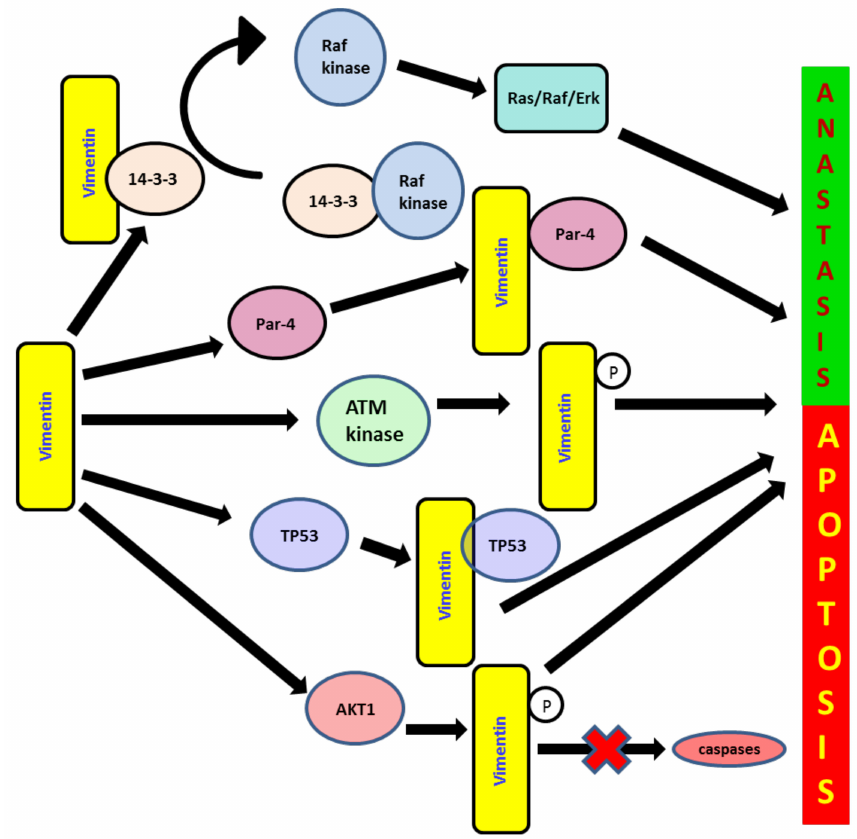
Figure 3. Loss of apoptosis and anastasis, “recovery from the brim of death”, are the important tools employed by cancer cells to progress, resist therapeutic agents and sustain the complex mi- croenvironmental factors. Vimentin deregulates apoptosis and consequently supports cancer growth via its interaction through 14-3-3 protein-mediated mechanisms and prevents its free availability to regulate different molecular cascades of apoptosis, cell cycle and cancer development via oncogenic Raf, Bad, Bax Cdc25 and AKT interactions. It also binds to the protein prostate apoptosis response-4 (Par-4), preventing its secretion and consequently disrupting its apoptotic activities. It is a key downstream effector of ATM-mediated signalling cascades to inhibit apoptotic events during the DNA damage response to chemotherapeutic agents, and it upregulates early cell migration and the related escape from apoptotic death. It also induces nuclear translocation of cytoplasmic p53, thus causing downregulation of p53-mediated